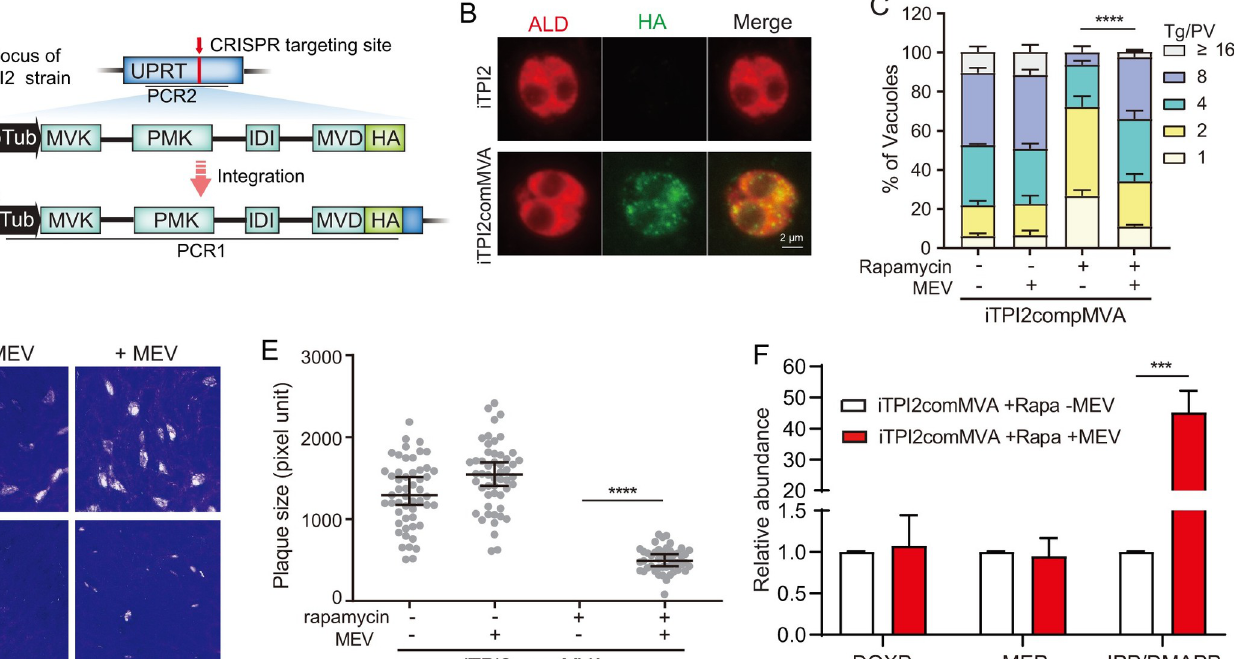
PLOS Pathogens| https://doi.org/10.1371/journal.ppat.1011009 November 30,